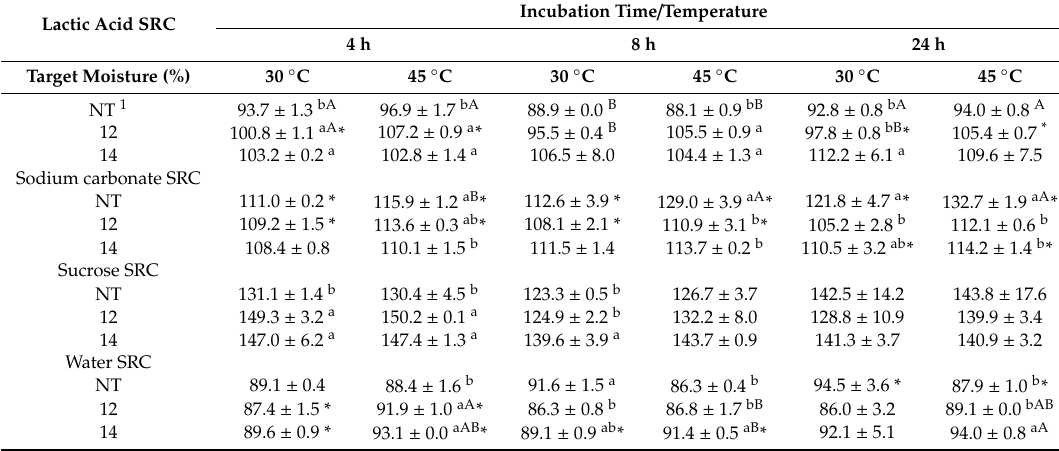
Table 4. Solvent retention capacity (SRC) of tempered intermediate wheatgrass flour. Incubation Time / Temperature Lactic Acid SRC 4 h 8 h 24